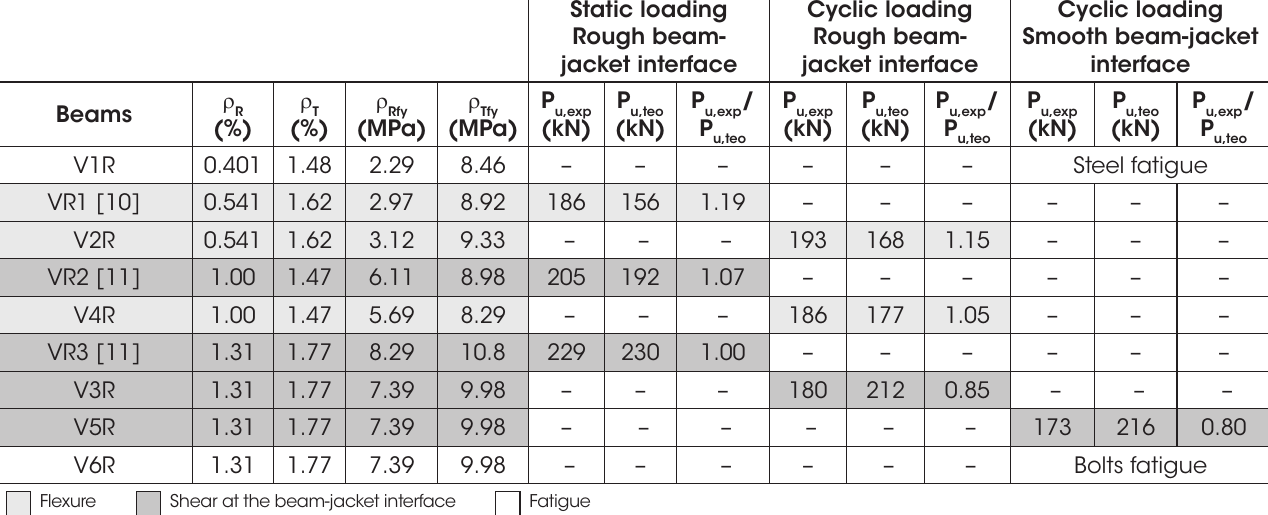
Experimental and theoretical failure loads of strengthened beams of [1] and previous work [10] and [11]